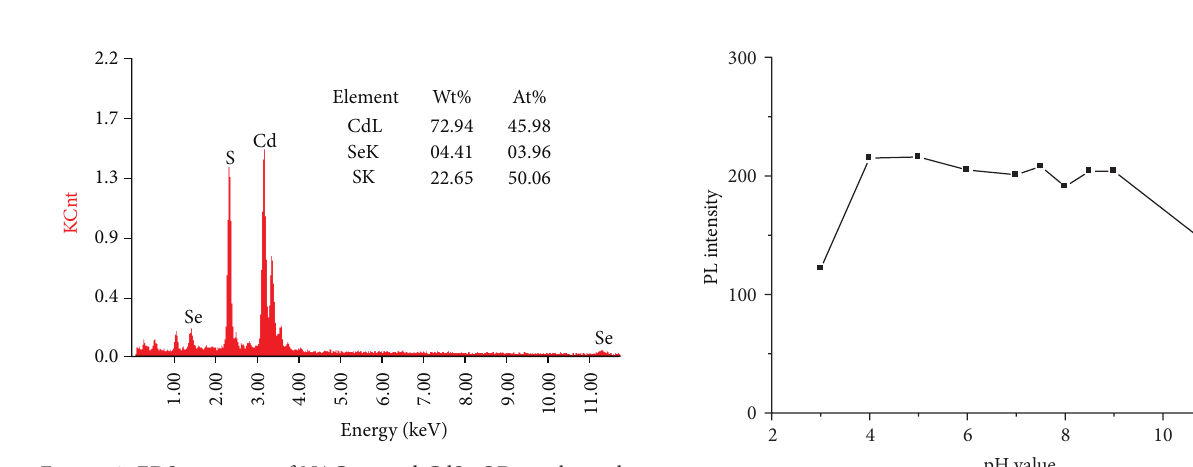
Figure 8: EDS spectrum of NAC-capped CdSe QDs at the molar ratio of Cd: Se = 1 :0.05. Figure 9: PL intensity of NAC-capped CdSe QDs at various pH